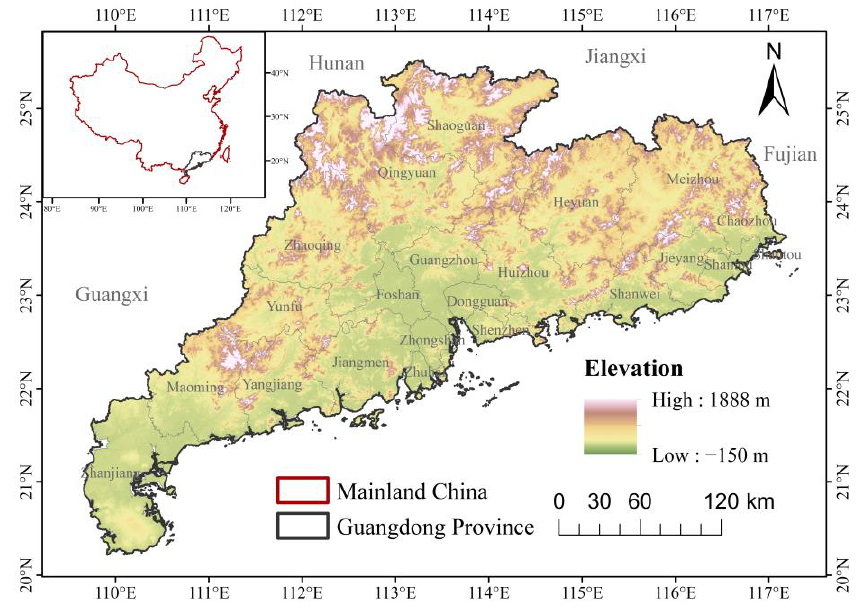
Figure 1. Study area and its location in Mainland China.